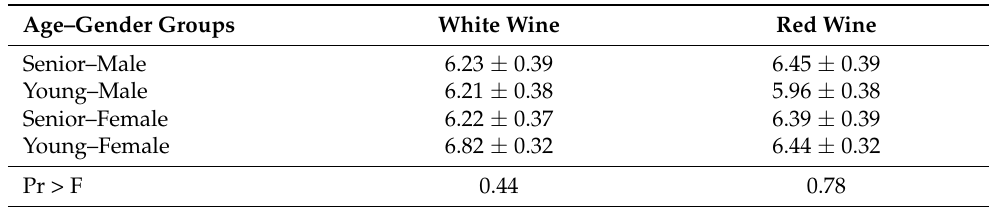
Table 2. Mean values with standard deviation of hedonic response (liking) using a 9-point scale by age–gender groups in both wines.